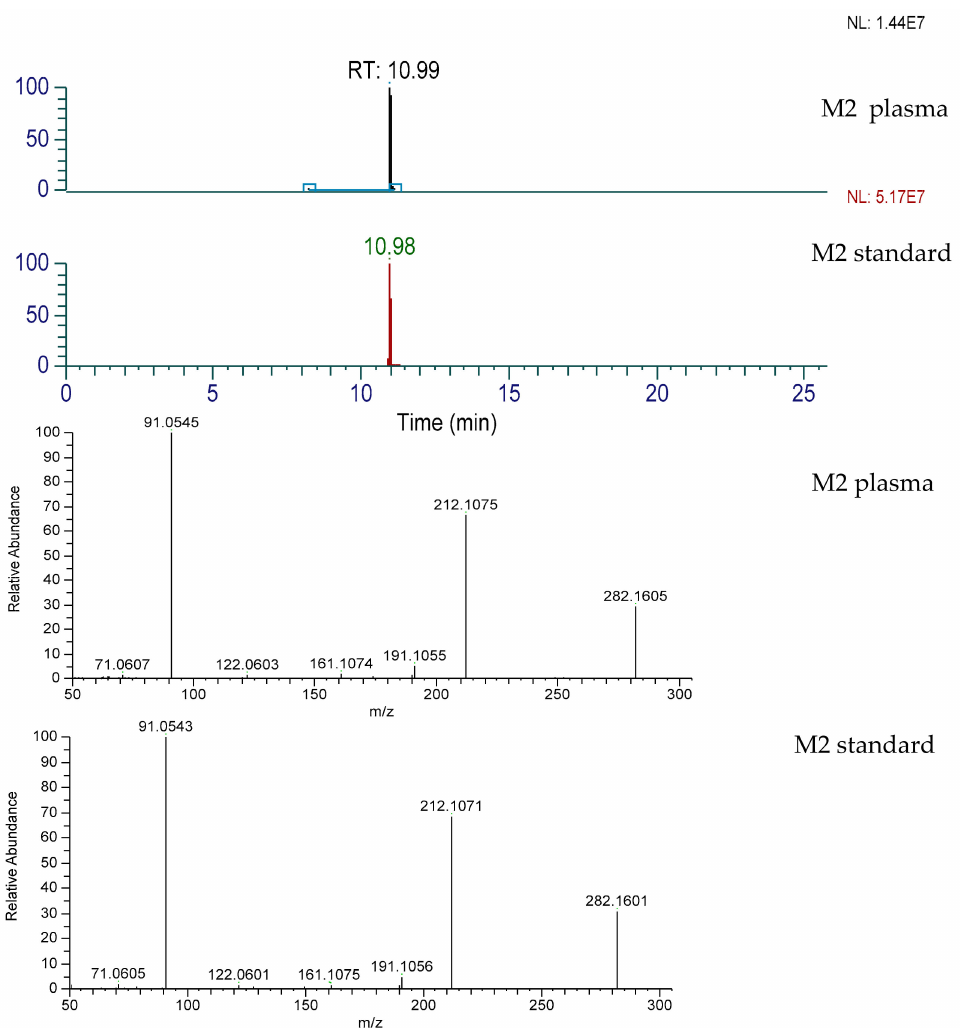
Figure A3. Chromatograms and MS2 spectra of MW281 (M2): synthesized and detected in plasma of volunteers after administration of antazoline mesylate.